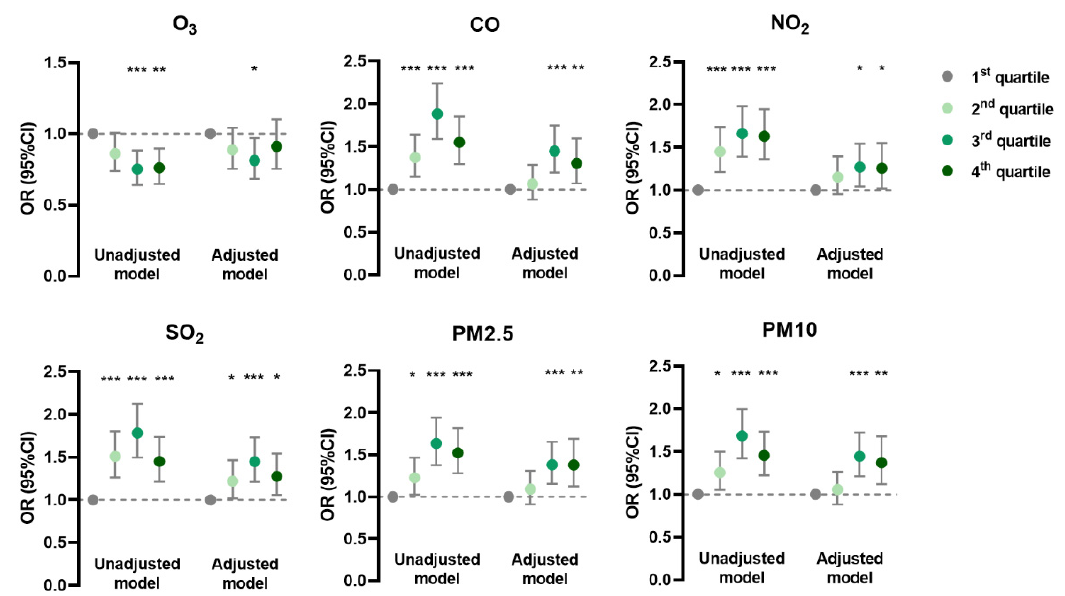
Figure 2. Association between chronic hand eczema and adjusted daily dose of ambient air pollutants. The unadjusted model describes the crude OR; the adjusted model was adjusted for demographic variables, behavioral habits, and environmental factors. * 0.01 < p < 0.05; ** 0.001 < p < 0.01; *** p < 0.001. The association of second-hand smoke (SHS) with AD, CHE, and urticaria was an- alyzed. Notably, a higher frequency of SHS exposure was positively correlated with the prevalence of all three diseases (Table 3). Other covariates including sex, family income, BMI, and bath frequency for AD, CHE, and urticaria are shown in Table